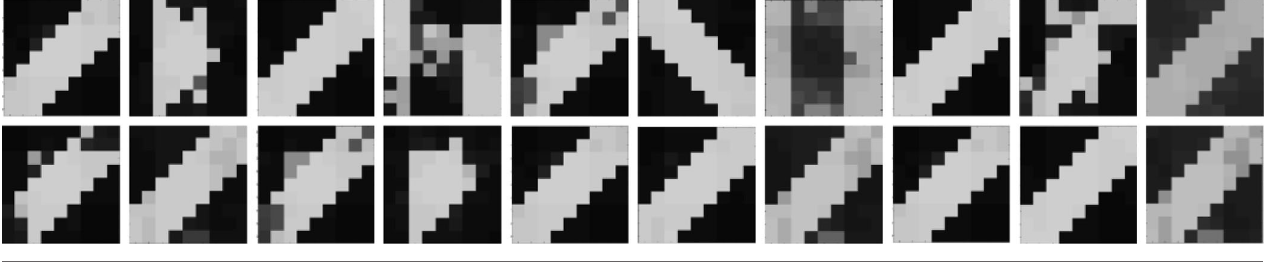
Table 4B | Summary of 20 simulations of orientation selective cell with different initial conditions but same random-inside-epoch order of input patterns.